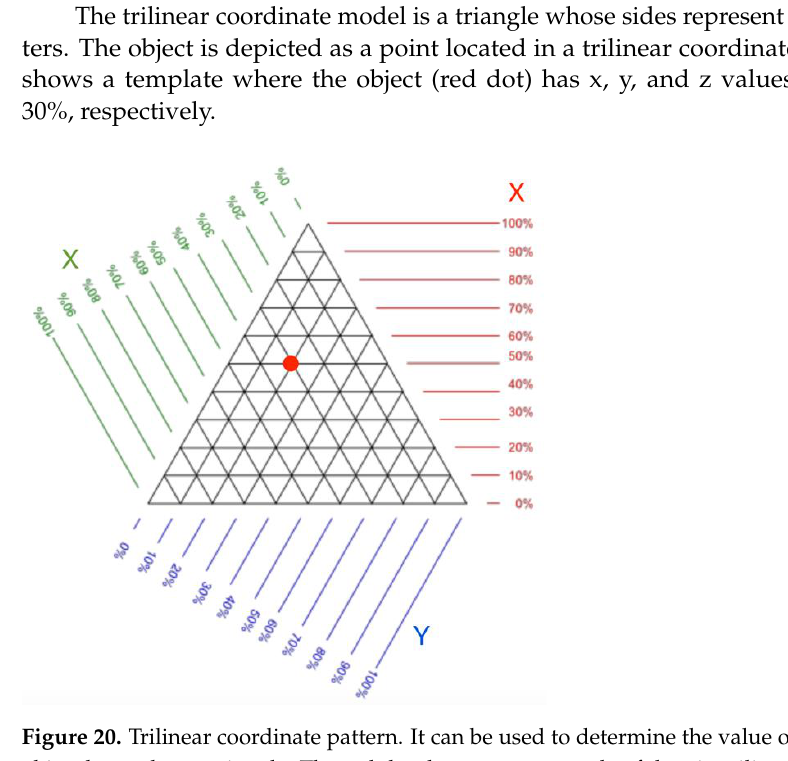
an object located on a triangle. The red dot denotes an example of data in trilinear coordinates [62].